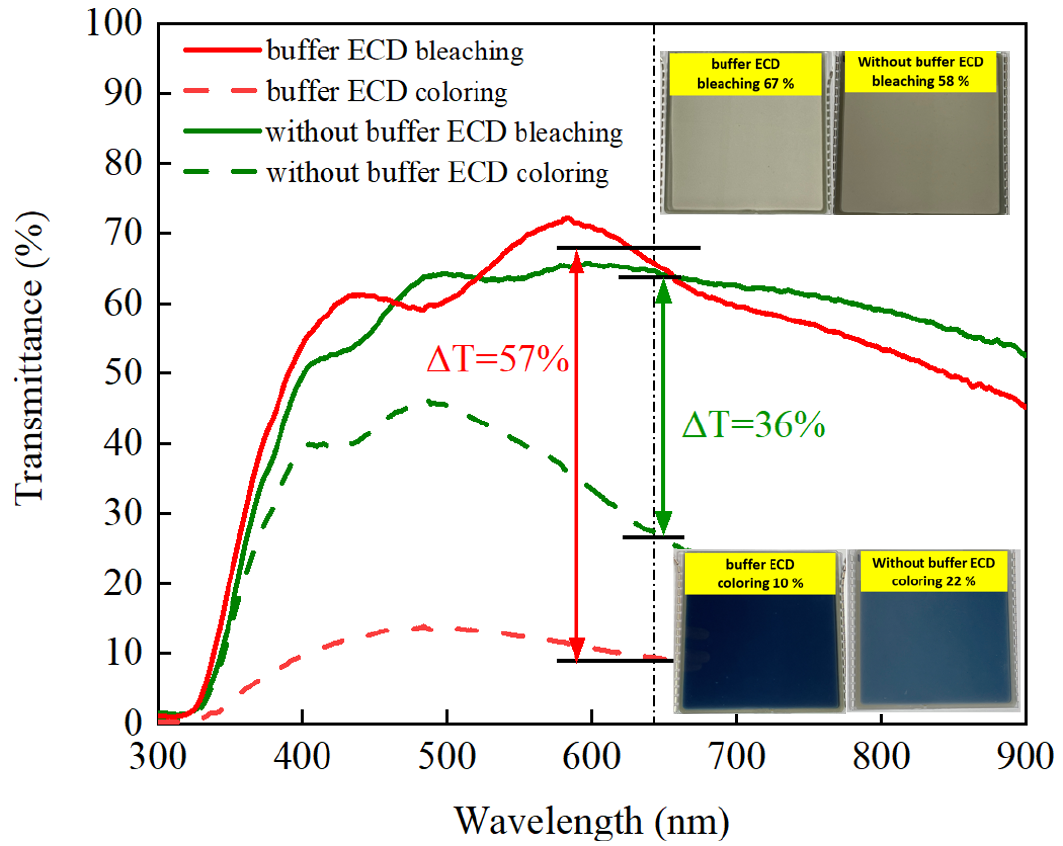
Figure 10. The optical transmittance spectra and image comparison with buffered ECD and ECD without buffer in bleaching/coloring states.